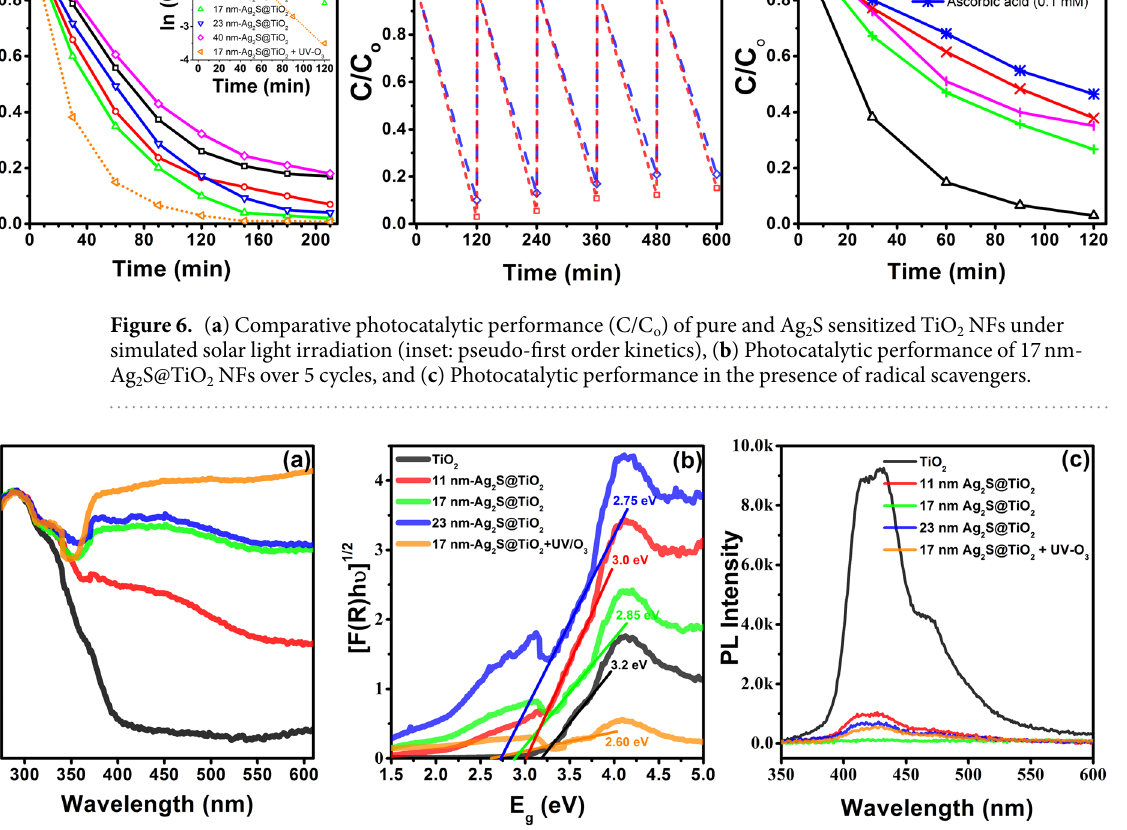
Figure 7. ( a ) UV-vis diffuse reflectance spectra of Ag 2 S@TiO 2 NFs (converted to absorbance), ( b ) Kulbelka- Munk transformation showing the estimated bandgaps, and ( c ) the photoluminescence spectra recorded after 325 nm laser